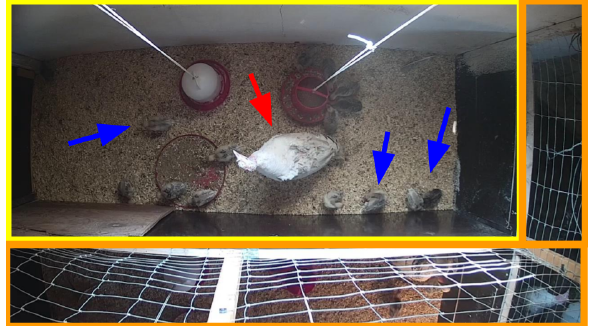
Figure 4. An example of the scene recorded by the used video sequences. The red arrow shows the adult turkey, blue arrows show the chicks. The yellow rectangle shows the main pen, the orange rectangles show the adjacent pens. ©IPI, TiHo Hannover